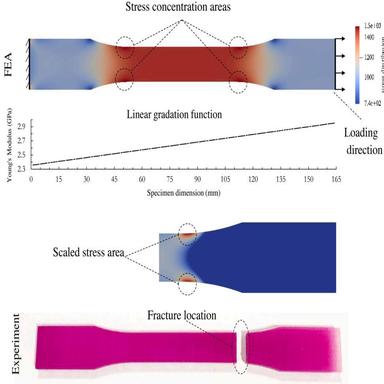
Stress field from FEA simulation and fractured specimen from experiment.